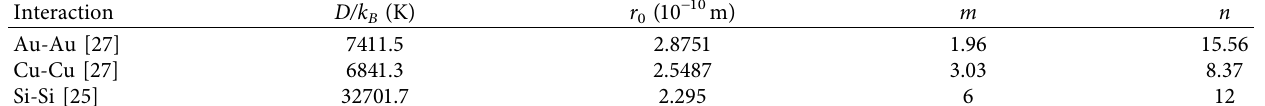
Table 1: Mie–Lennard-Jones potential parameters for interactions Au-Au, Cu-Cu, and Si-Si. Interaction